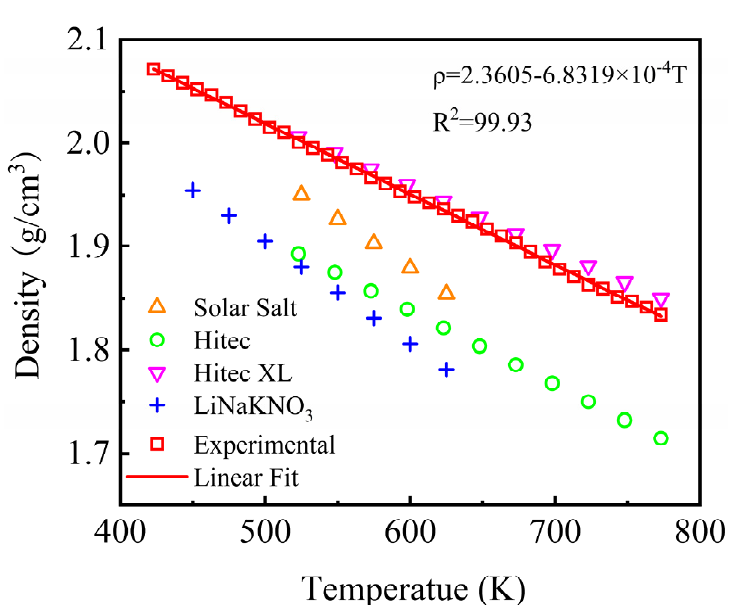
Figure 9. Densities of the NaNO 3 -KNO 3 -Ca(NO 3 ) 2 (16:48:36 wt%) eutectic ternary salt and other currently used nitrate/nitrite systems.